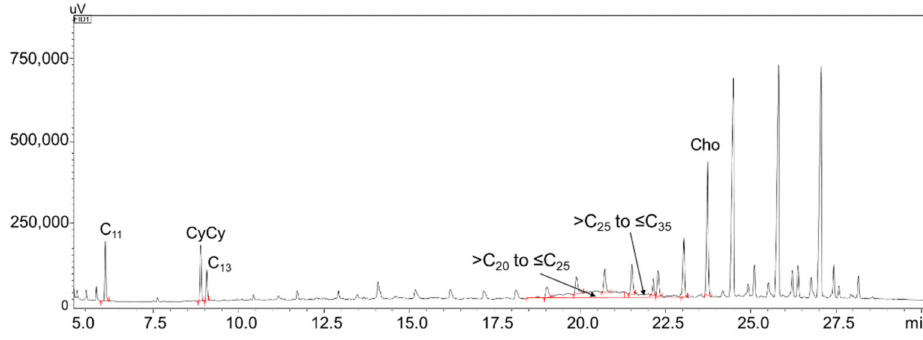
Figure 3. LC–GC expansion of the MOSH fraction of sample 3, along with IS and C-fractions. The MOSH contamination for each C-fraction, for the analyzed samples, is shown in Table 2. As can be seen, all the samples subjected to analysis presented a contamination in the >C 25 – ≤ C 35 range, with an average value of 26.9 ppm; six samples were character- ized by a contamination in the >C 20 – ≤ C 25 range, with an average value of 50.8 ppm; a contamination in the >C 35 – ≤ C 40 range was found in nine samples, with an average value of 2.6 ppm. Only sample 2 presented a contamination in the >C 16 – ≤ C 20 range (60.9 ppm). Finally, contamination in the >C 40 – ≤ C 50 range was present only in samples 1 and 6, at low concentration levels, specifically 1.8 and 0.6 ppm, respectively. Table 2. Analyzed samples along with MOSH and MOAH C-fractions, and